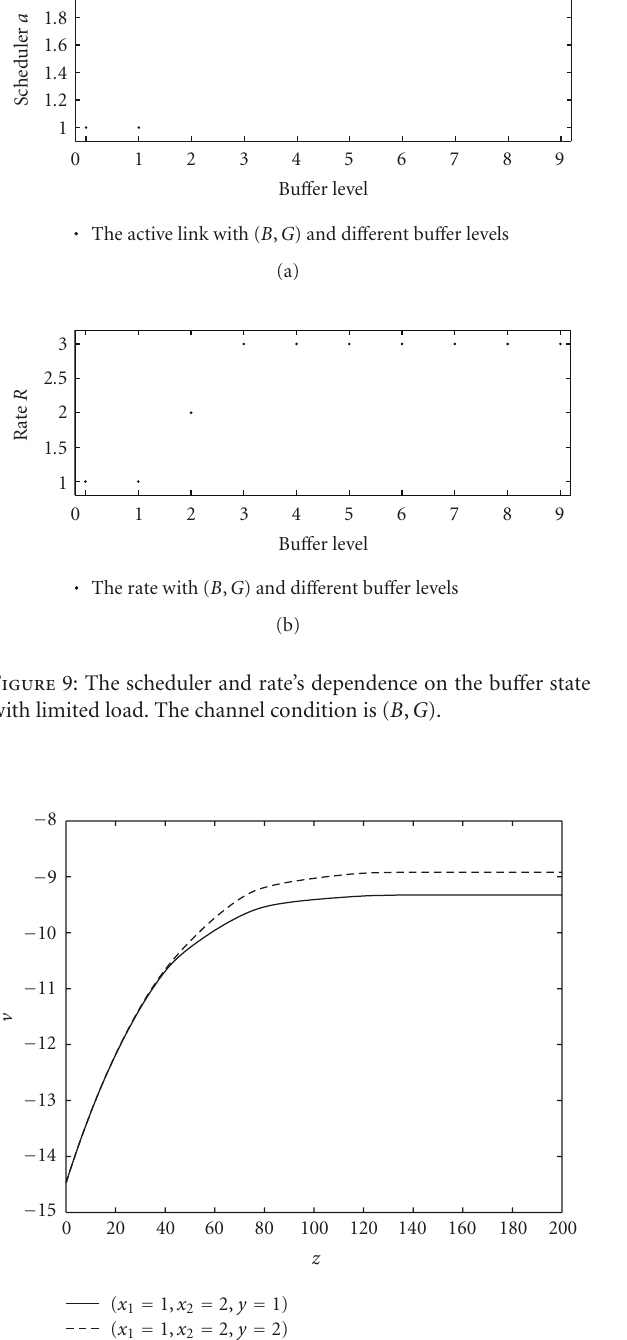
Figure 10: v as a function of bu ff er level when the channel states are fixed.